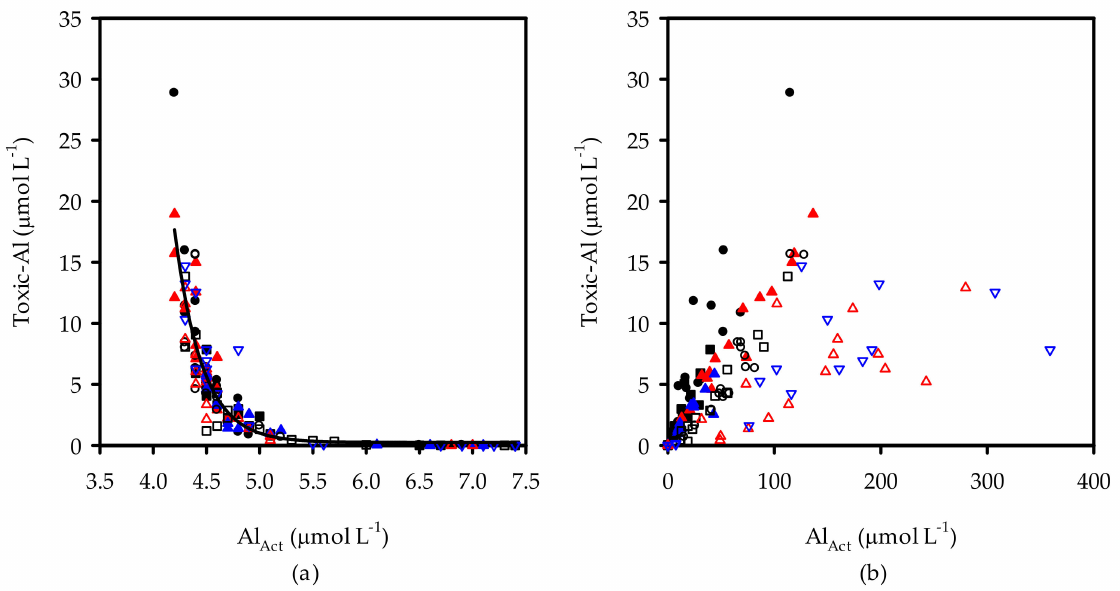
Figure 8. Relationship between Toxic-Al ( a ) pH Soln ( Toxic − Al = 0.25 + 2.29 x 10 8 x exp ( − 3.90 x pH Soln ) , r 2 = 0.81 and ( b ) Al Soln ST experiment treatments C ( ), L ( (cid:3) ), G ( (cid:52) ), and L + G ( (cid:53) ), and for the LT experiment treatments C ( • ), L ( (cid:4) ), G (cid:35) ( (cid:78) ), and L + G ( (cid:72)